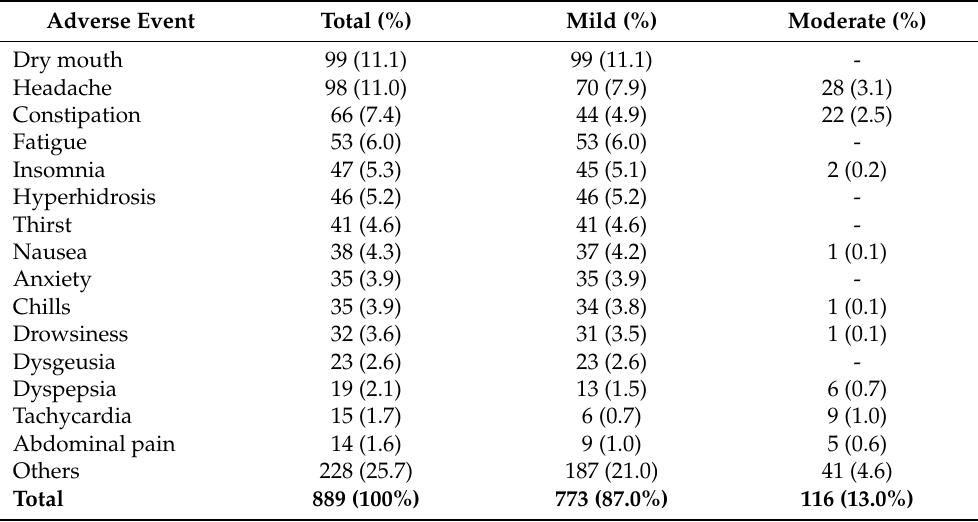
Table 4. Main adverse events reported by patients with obesity who received mazindol for